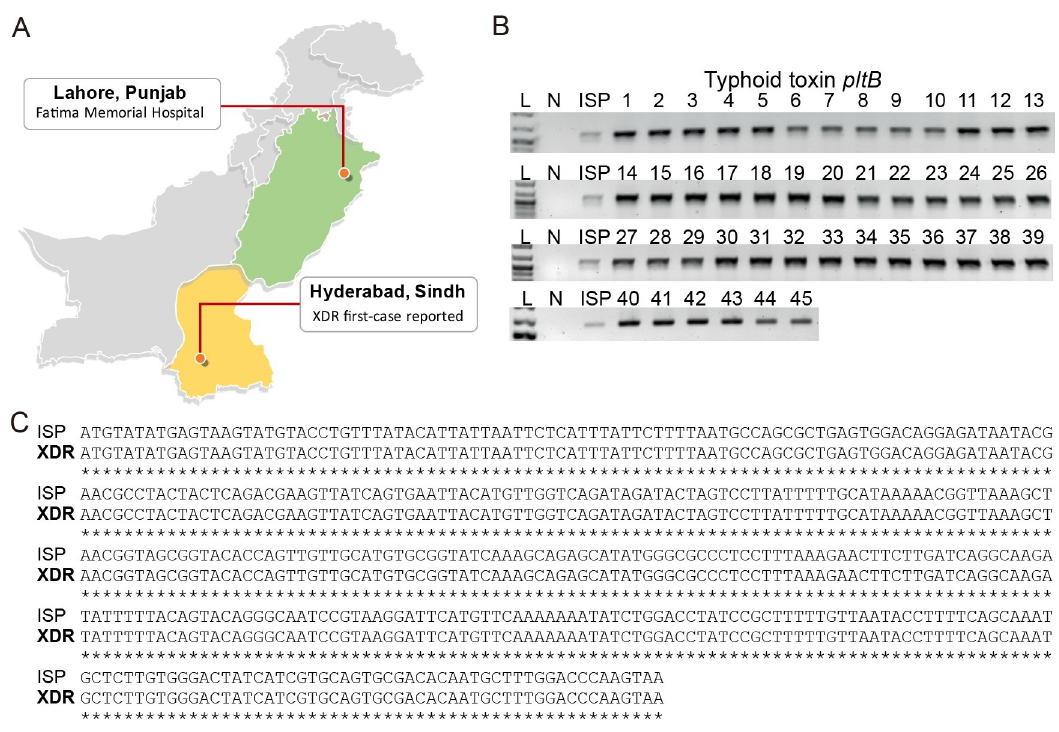
Fig 1. XDR S . Typhi strains isolated from children ages 1–13 years old. A , Illustration showing the geographical location that XDR S . Typhi characterized in this study was isolated compared to the location that the first case of XDR S . Typhi was reported. B , PCR reactions of 45 XDR isolates for typhoid toxin pltB . C , pltB sequences from all 45 XDR isolates (XDR, one representative is shown) were identical to typhoid toxin pltB sequence of S . Typhi ISP2825 (ISP). ISP, antibiotic-susceptible S . Typhi ISP2825, GenBank accession number CP080960. N, negative control containing all PCR components except for S . Typhi genomic DNA. See S1 and S2 Tables for sample information and antibiotic breakpoints.